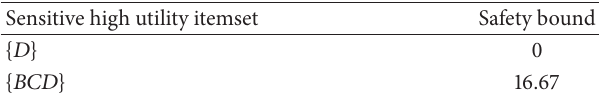
Table 6: Safety bounds for the sensitive high utility